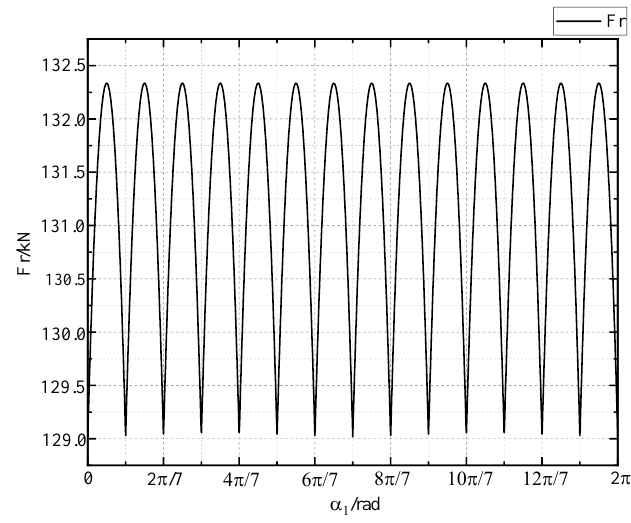
Figure 7. Diagram of the radial force of the gear.